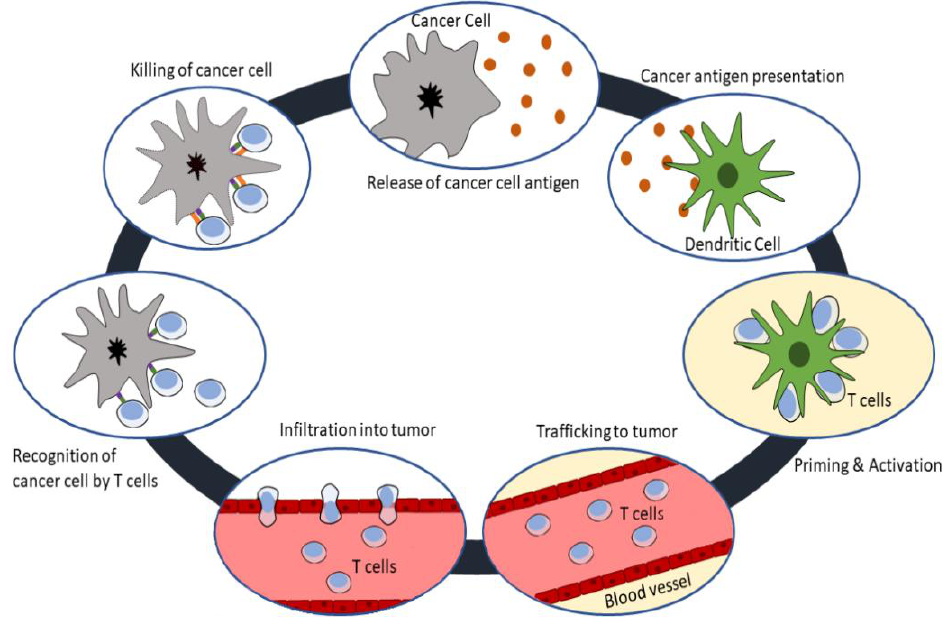
Figure 1. The cancer immunity cycle. This cycle starts with the release of antigens from cancer cells and ends with the formation of immunity to the cancer cell, and many different cells play a role in this natural process .